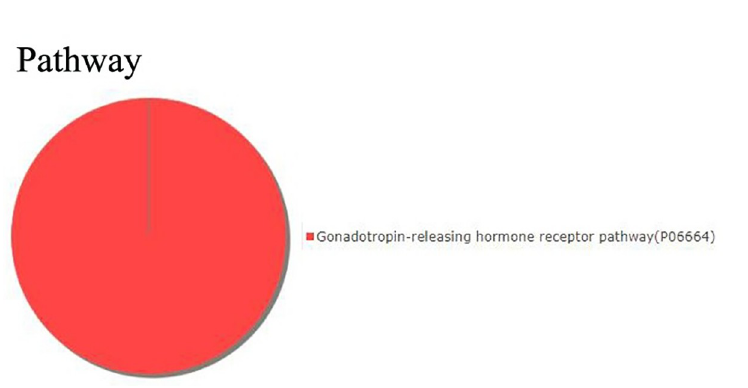
Fig 4. The differentially expressed protein-coding genes were clustered and found to be enriched in the Gonadotropin-releasing hormone receptor pathway.